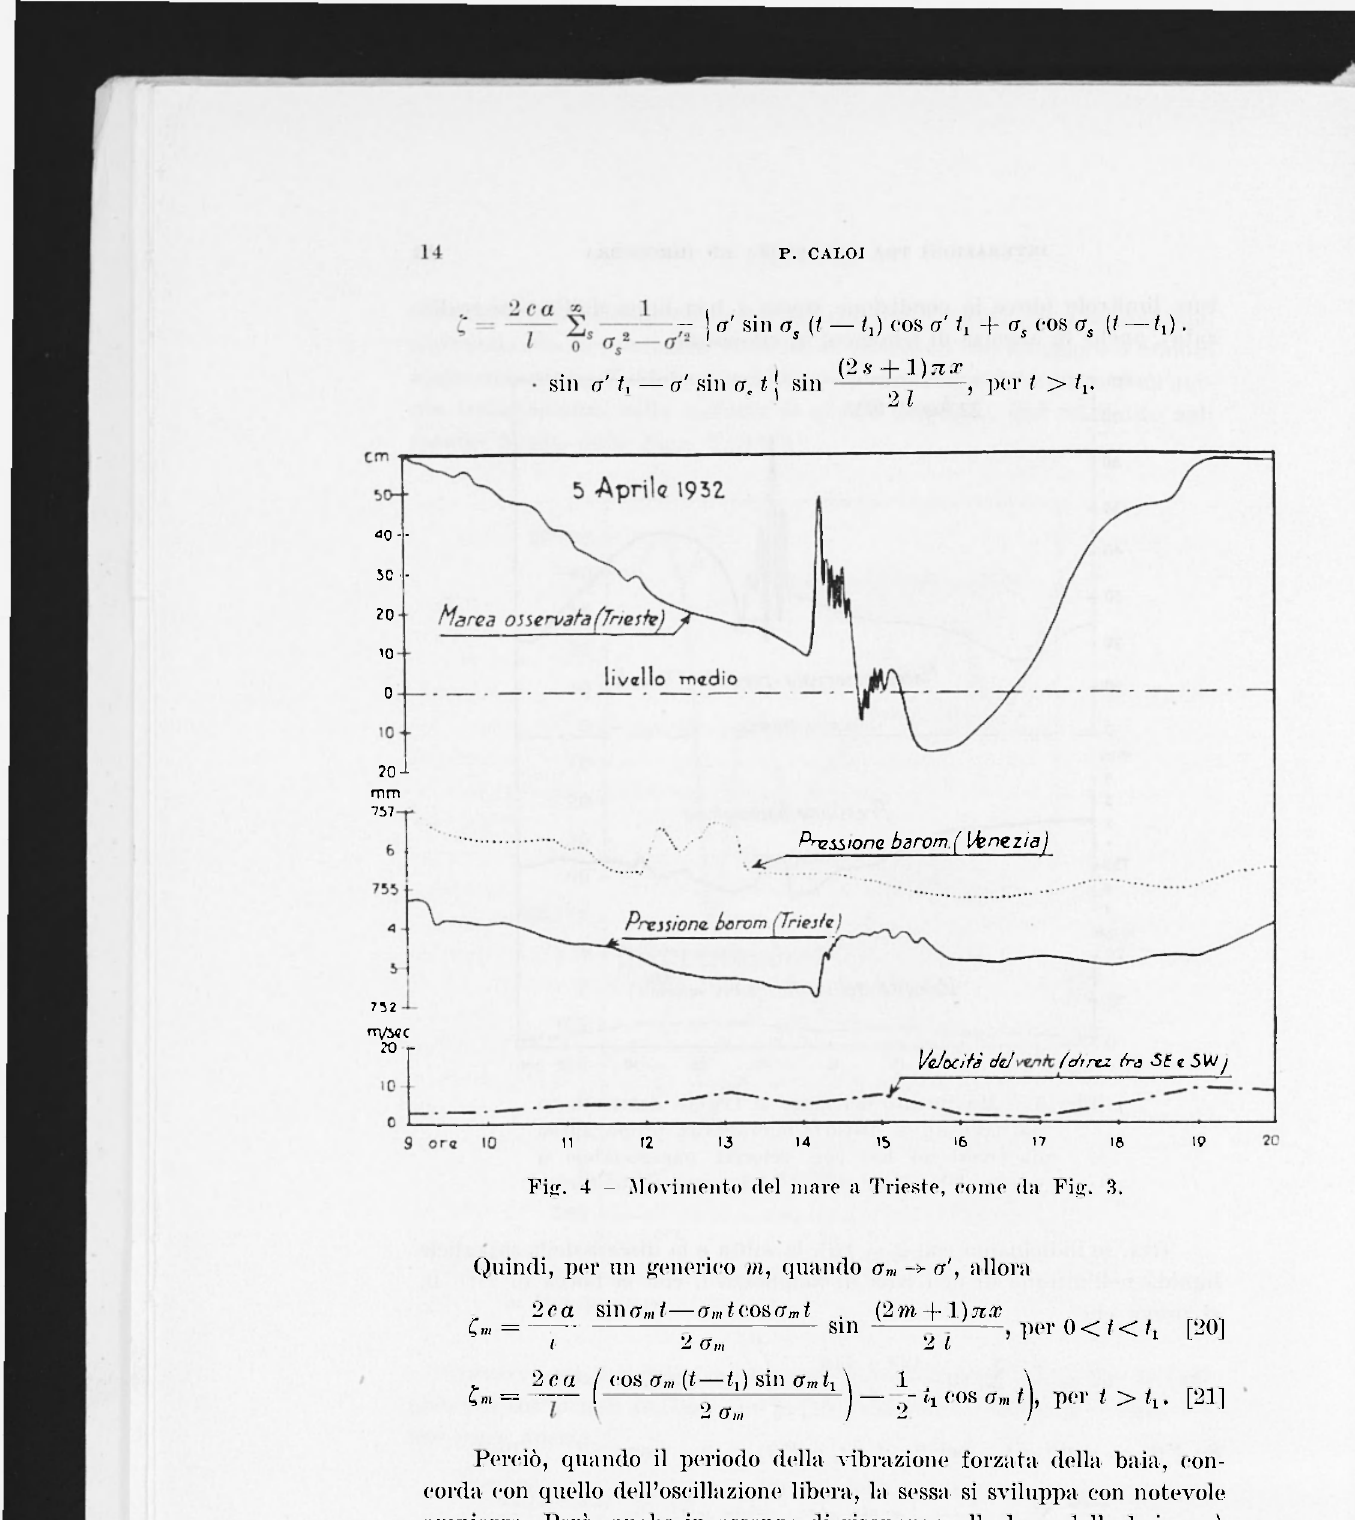
Fig. 4 - Movimento del mare a Trieste, come da Fig.